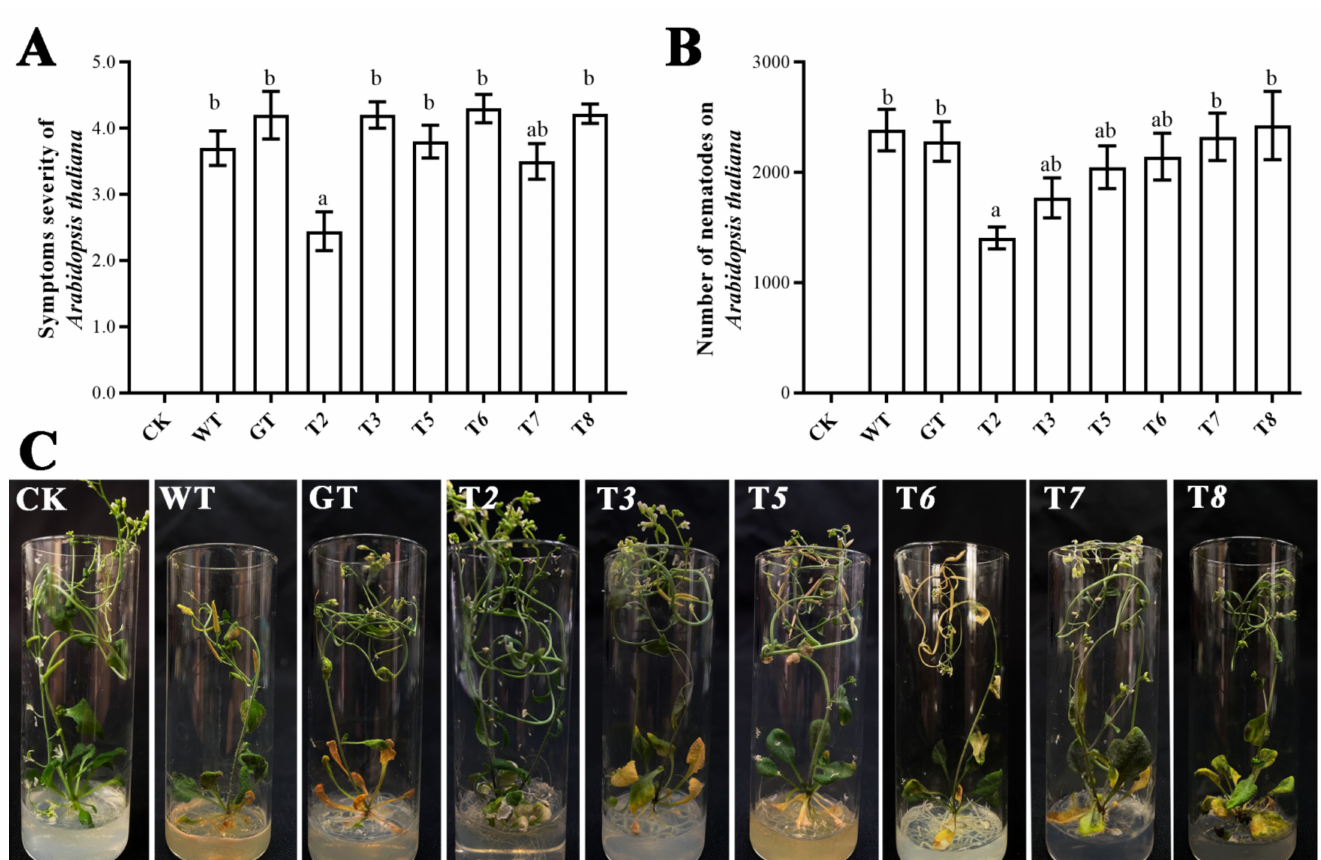
Figure 4. Pathogenicity of nematodes to Arabidopsis thaliana after silencing Ab-far-n of Aphelenchoides besseyi . ( A ) Symp- tom severity of Arabidopsis thaliana inoculated with A. besseyi . ( B ) Reproduction of A. besseyi inoculated on A. thaliana . ( C ) Symptoms of A. thaliana caused by A. besseyi . CK, blank control; WT, nematodes cultured on wild-type B. cinerea ; GT, nematodes cultured on eGFP hpRNA transgenic B. cinerea ; T 2 /T 3 /T 5 -T 8 , nematodes cultured on either Ab-far-2 , Ab-far-3 , or Ab-far-5 — Ab-far-8 hpRNA transgenic B. cinerea , respectively. Values are means ± standard error, n = 10. Different lowercase letters denote values that are significantly different from each other ( p < 0.05; Tukey’s